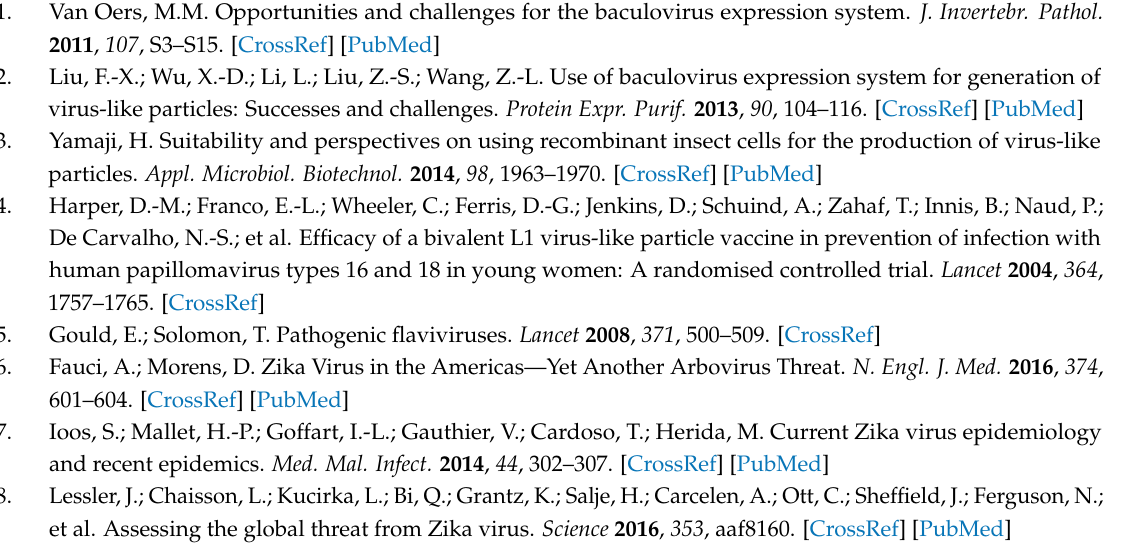
Figure S1: Ultrathin sections of recombinant baculoviruses expressing flavivirus E proteins-infected Sf9 cells. Figure S2: AMS inhibited ZIKV infection in BHK21 cells. Figure S3: Detection of free thiols in ZIKV E